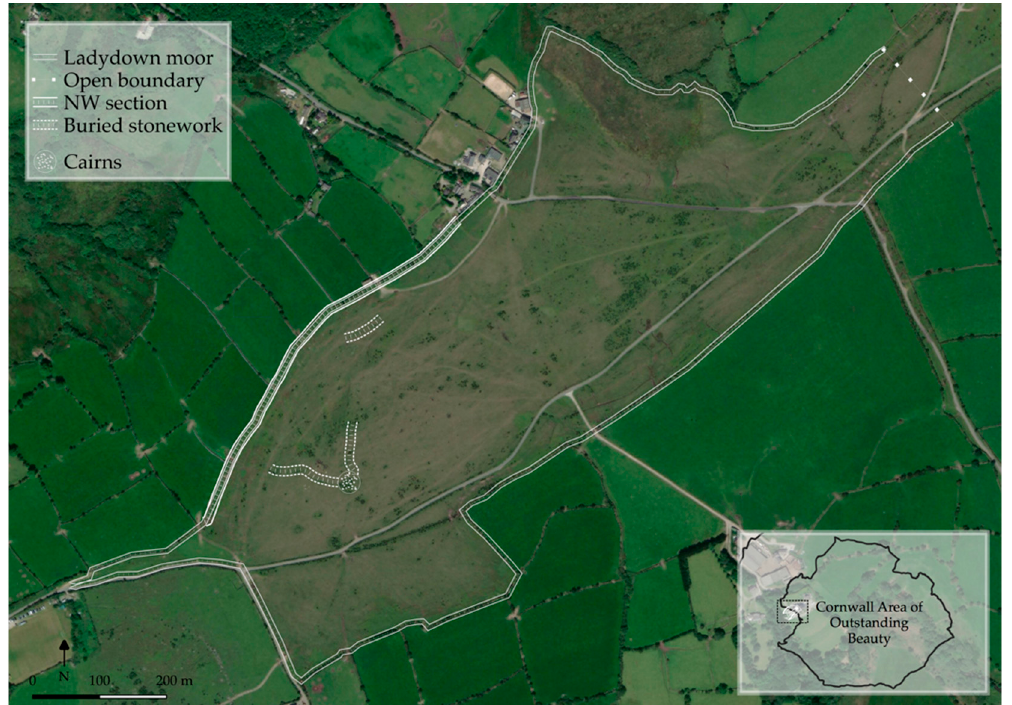
Figure 4. Orthoimage highlighting Ladydown Moor and its introduced structures. Source: ESRI World Imagery (Esri, DigitalGlobe, GeoEye, i-cubed, USDA FSA, USGS, AEX, Getmapping, Aerogrid, IGN, IGP, swisstopo, and the GIS User Community).